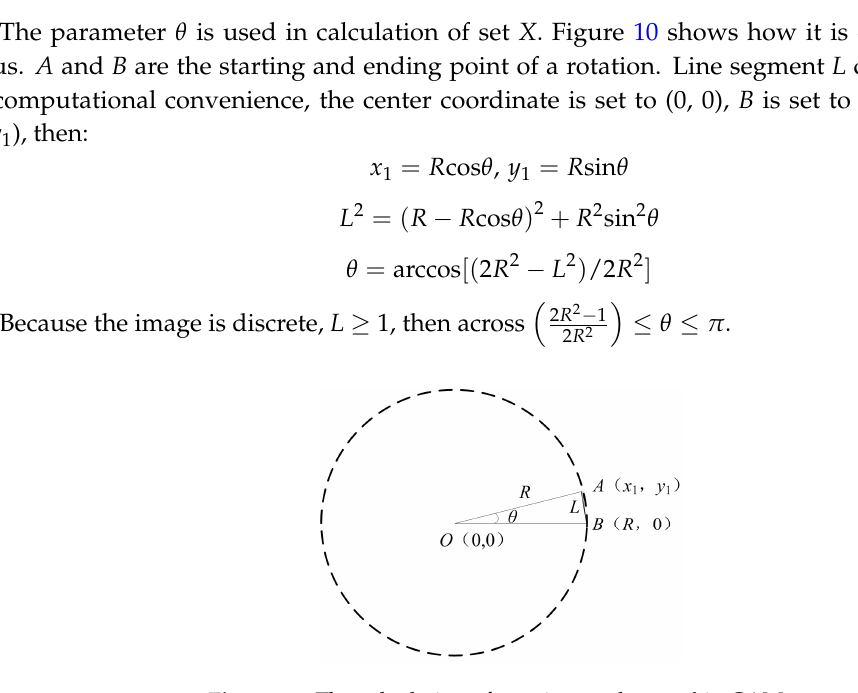
Figure 10. The calculation of rotation angle step θ in CAM.